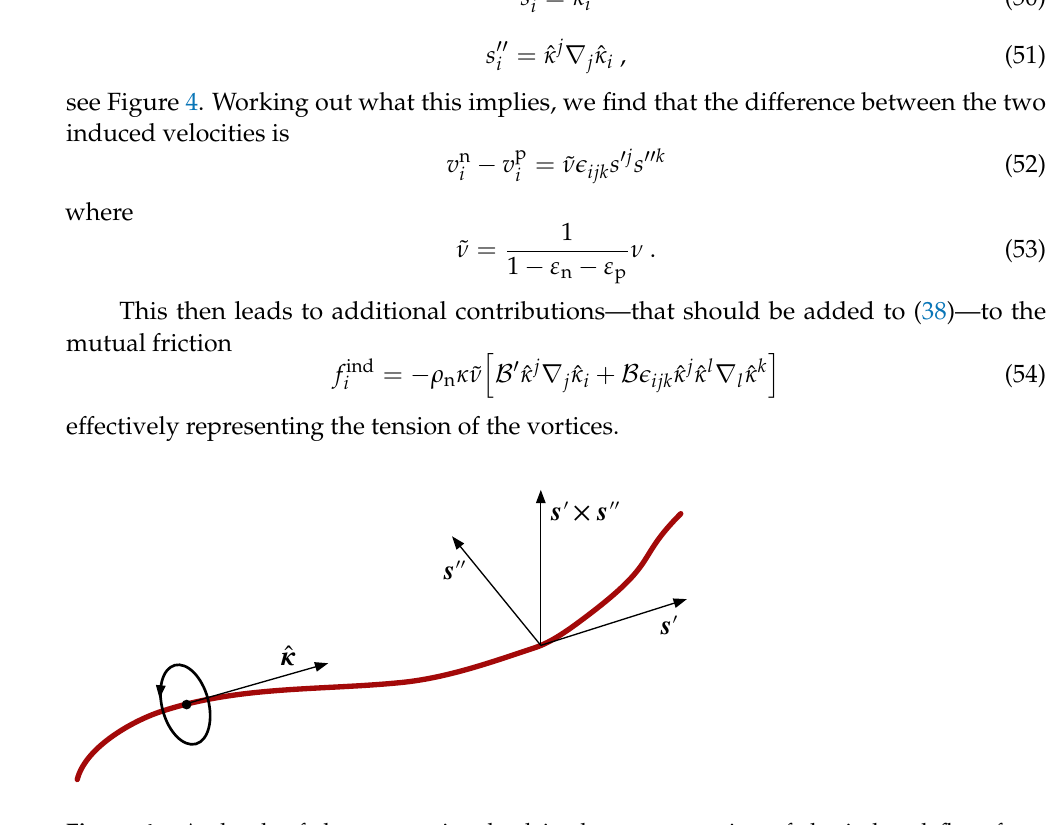
Figure 4. A sketch of the vectors involved in the representation of the induced flow for a curved